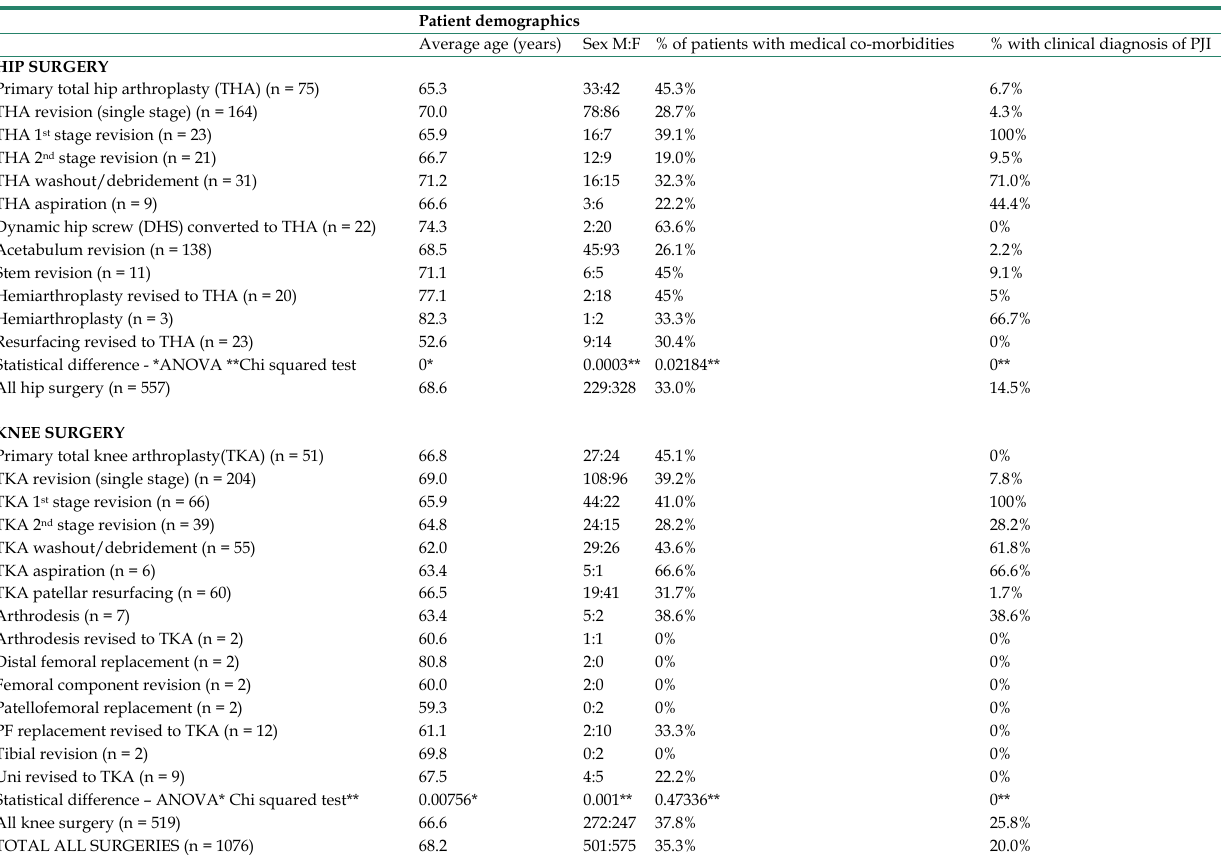
Patient demographics Average age (years) Sex M:F % of patients with medical co-morbidities % with clinical diagnosis of PJI